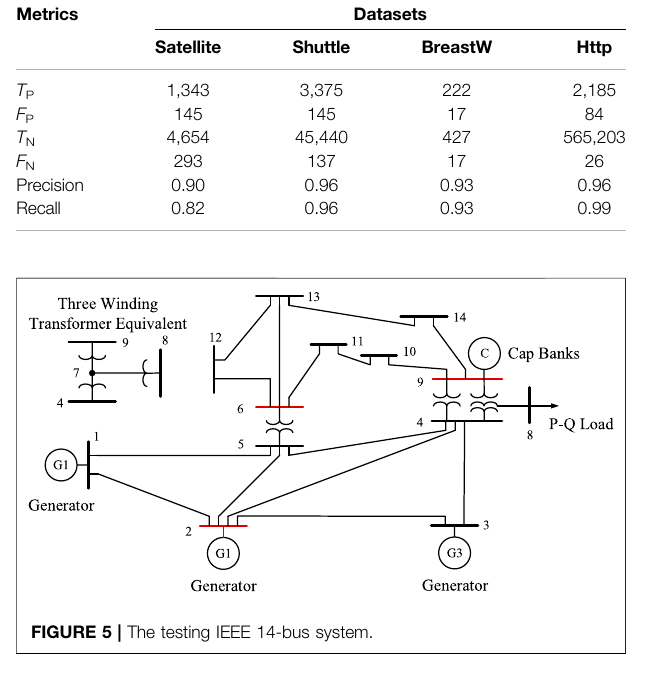
FIGURE 5 | The testing IEEE 14-bus